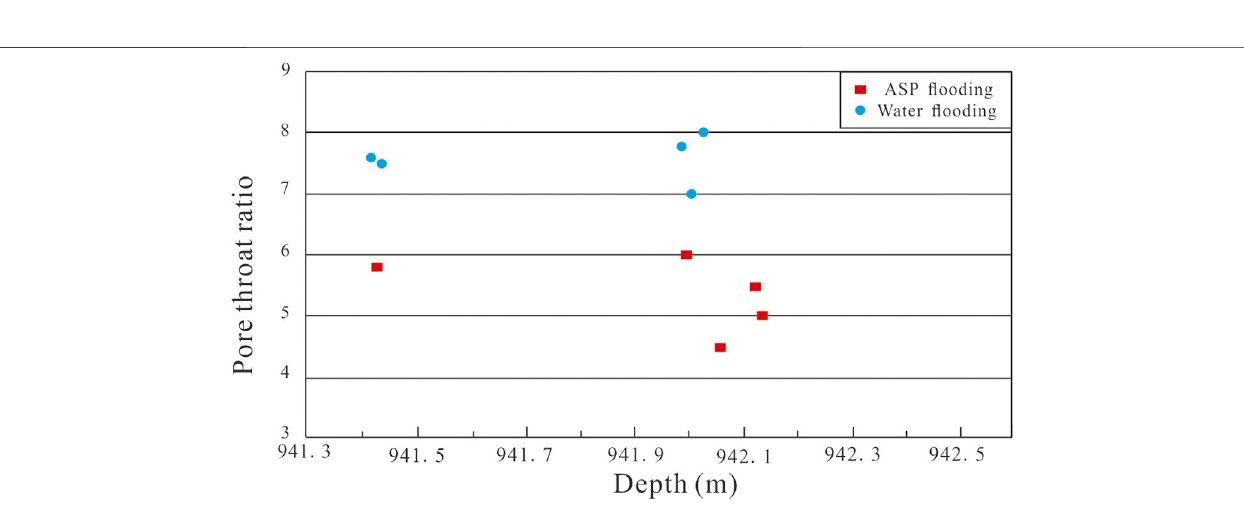
Frontiers in Earth Science |